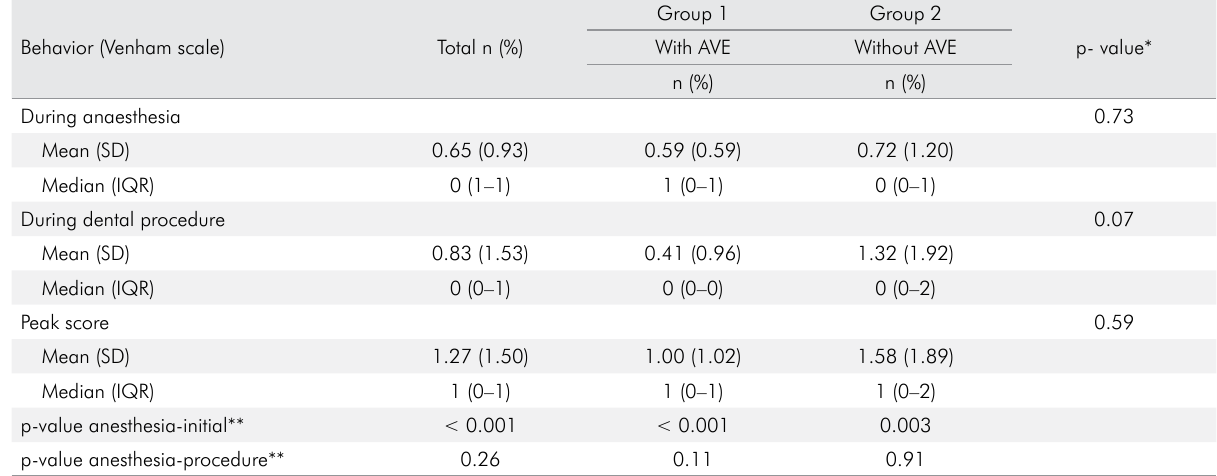
Table 2. Children behaviour according to Venham Scale during the local anaesthesia, during the procedure and peak score according to the use of audiovisual eyeglasses (AVE) (n =